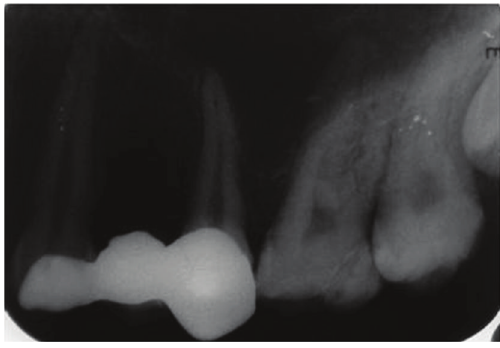
Figure 32: Right lateral view of teeth in functional harmony 2 years posttreatment.